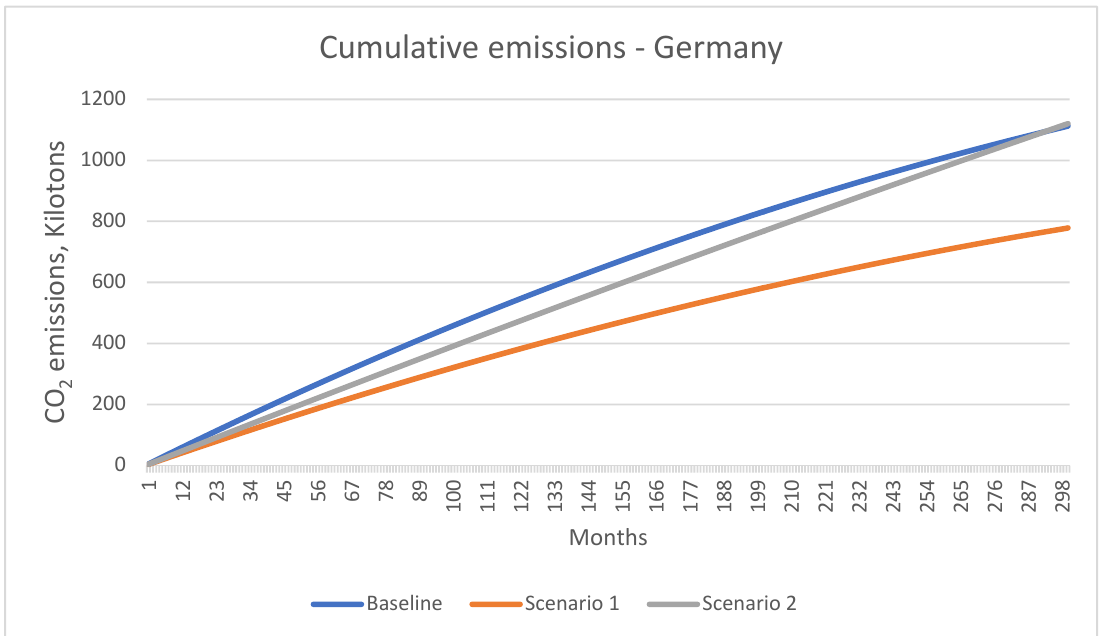
Figure 12. Comparison of expenditure through electricity consumption under different scenarios in a reference cement plant in DE.